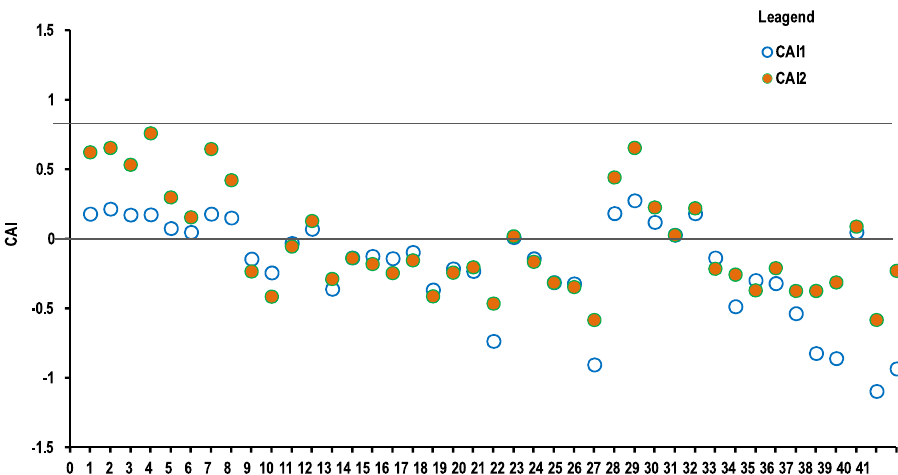
Fig. 7 Plot of CAI 1 and 2 of groundwater samples from the study area